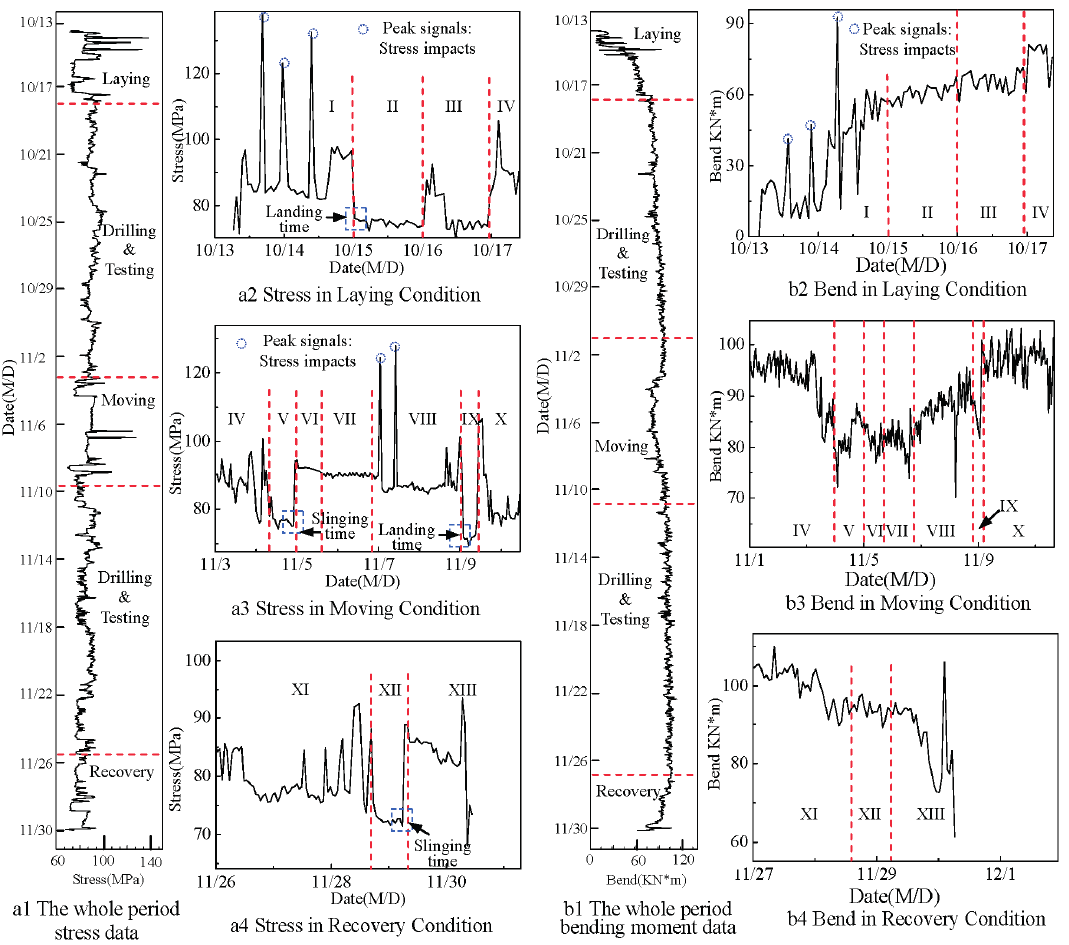
Figure 5. ( a ) Stress results; ( b ) bending moment